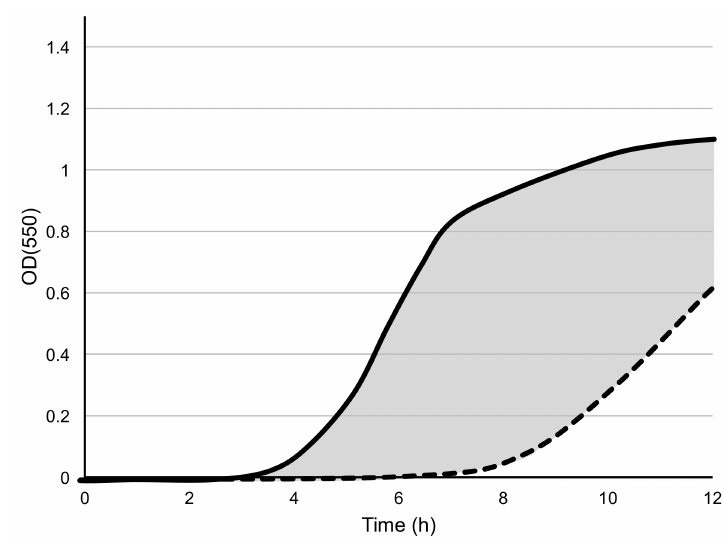
Figure 1. An illustration of the liquid assay score is derived by Equation (2). The equation calculates the area (grey) between the positive control (solid line) and the phage-inoculated culture (dashed line) and expresses this as a percentage of the total area under the positive control curve. No inhibition of bacterial growth (solid and dashed lines overlap) results in a score of zero and completes the absence of growth in the phage-inoculated culture (dashed line follows X-axis) would result in a score of